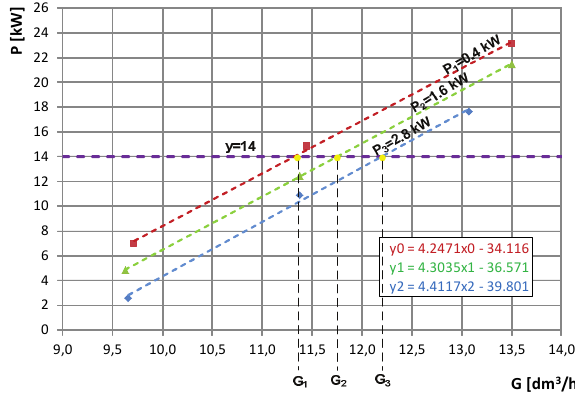
Fig. 5. Power on wheel vs. fuel consumption per hour for three options of electrical load The following values were calculated: G = 0.345 kWh1 dm 3 /kWh, G = 0.383 litres/kWh. Our further analysis kWh2 was based on the average value of GkWh = 0.364 dm 3